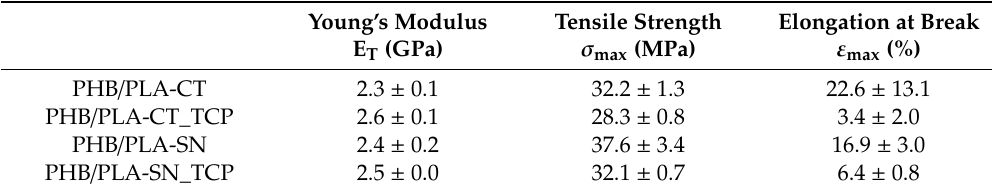
Table 6. The results of tensile